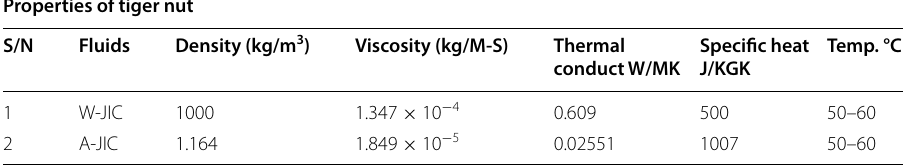
Table 1 Properties of sampled fluids Properties of tiger nut